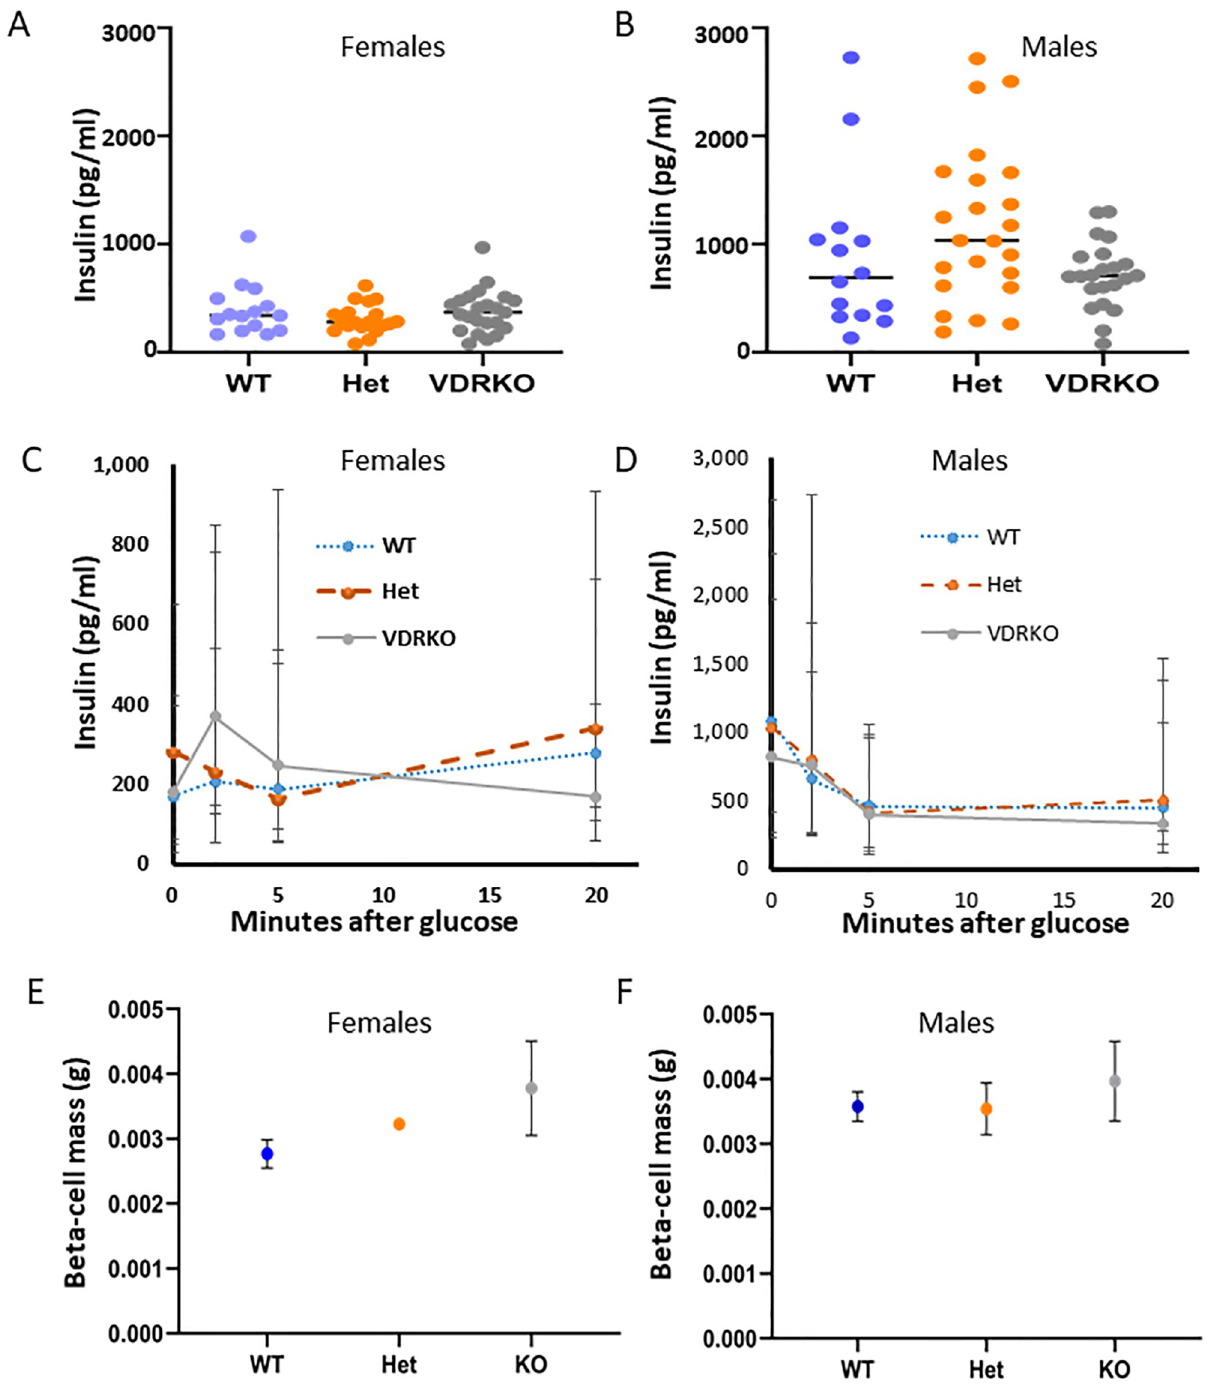
Fig 3. Fasting insulin and glucose stimulated insulin secretion in mice at 26 weeks of age. A) Female fasting insulin. B) Male fasting insulin. C) Female glucose stimulated insulin secretion. D) Male glucose stimulated insulin secretion. E) Beta cell mass in female mice. F) Beta cell mass in male mice. A and B show data for each mouse. C and D show median and interquartile ranges. N � 14 mice per group for figures A-D. Figures E and F show mean and SEM. N = 3 WT, 4 Het and 5 VDRKO females, and N = 4 WT, 5 Het and 9 VDRKO males for beta cell mass.